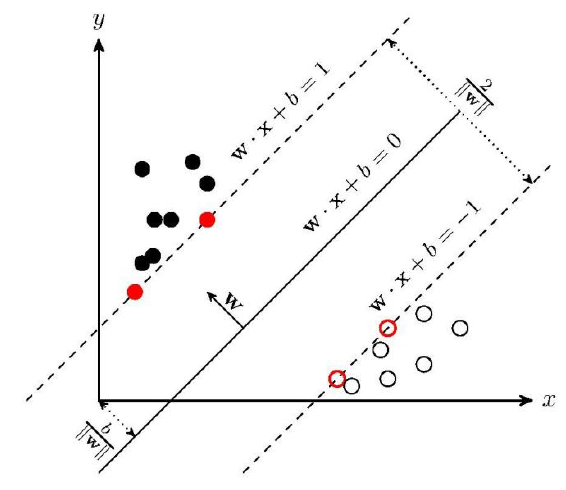
Figure 4. Basic principle of the SVM [49].